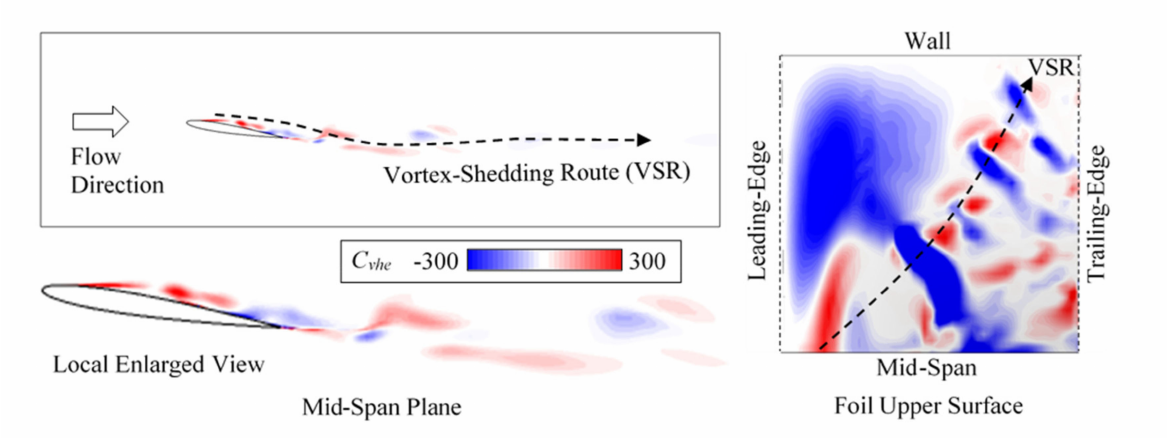
Figure 10. Velocity helicity coefficient C vhe on the mid-span plane and foil upper surface. VSR: vortex-shedding